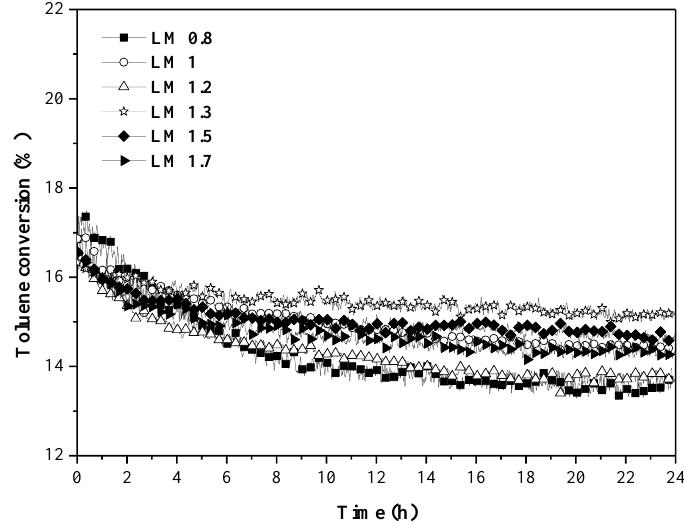
Figure 10. Long-run toluene oxidation test performed at ~17% of toluene conversion during 24 h. The